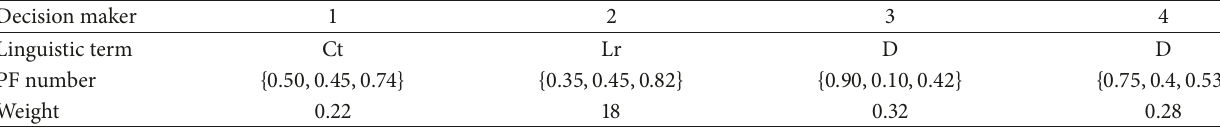
Table 11: Comparison of rank for each alternative.